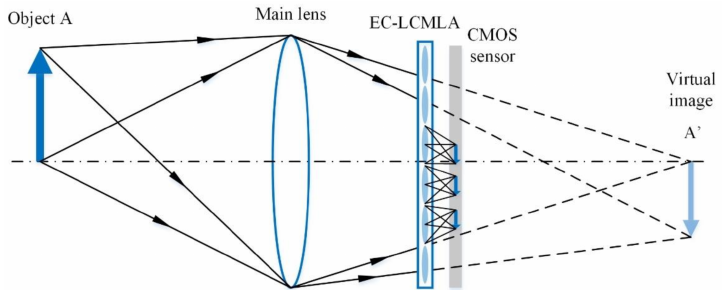
Figure 4. The schematic of the plenoptic imaging system based on EC-LCMLA working in Galilean